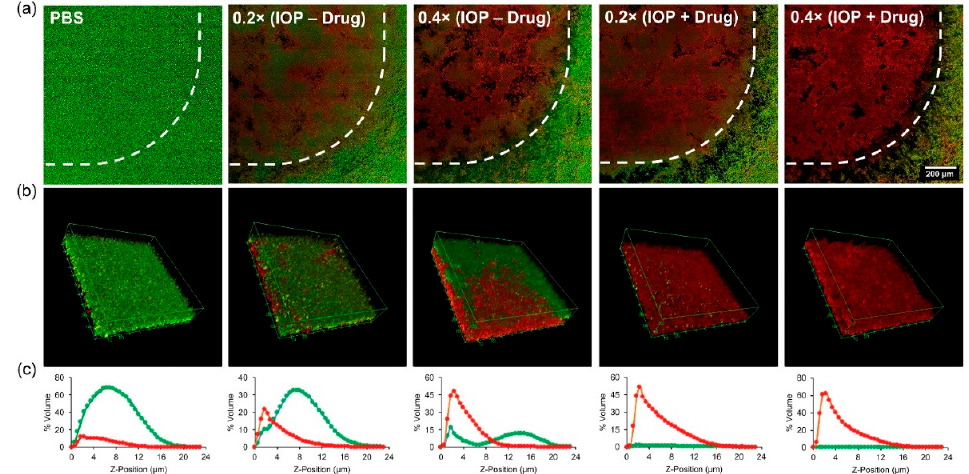
Figure 9. Anti-biofilm activity of iron oxide-encapsulated vesicles as a function of drug and SPION loading. ( a ) Tile scans of the Live (green) and dead (red) bacteria by laser scanning confocal micros- copy after 24 h within the magnetic field (pointed by dash line) at different concentrations (1 × stock equals to 100 μ g mL − 1 IOP; 50 μ g mL − 1 methicillin). ( b ) Three-dimensional reconstruction of z-stacks of the biofilm. ( c ) The percentage of biofilm volume occupied by live and dead bacteria as a function of biofilm depth (0 μ m = bottom) [111] (Reprinted with permission from [111]).